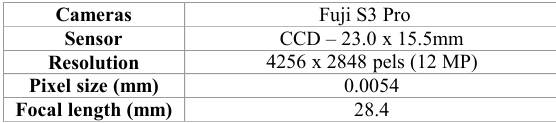
Table 1. Technical details of the camera used.